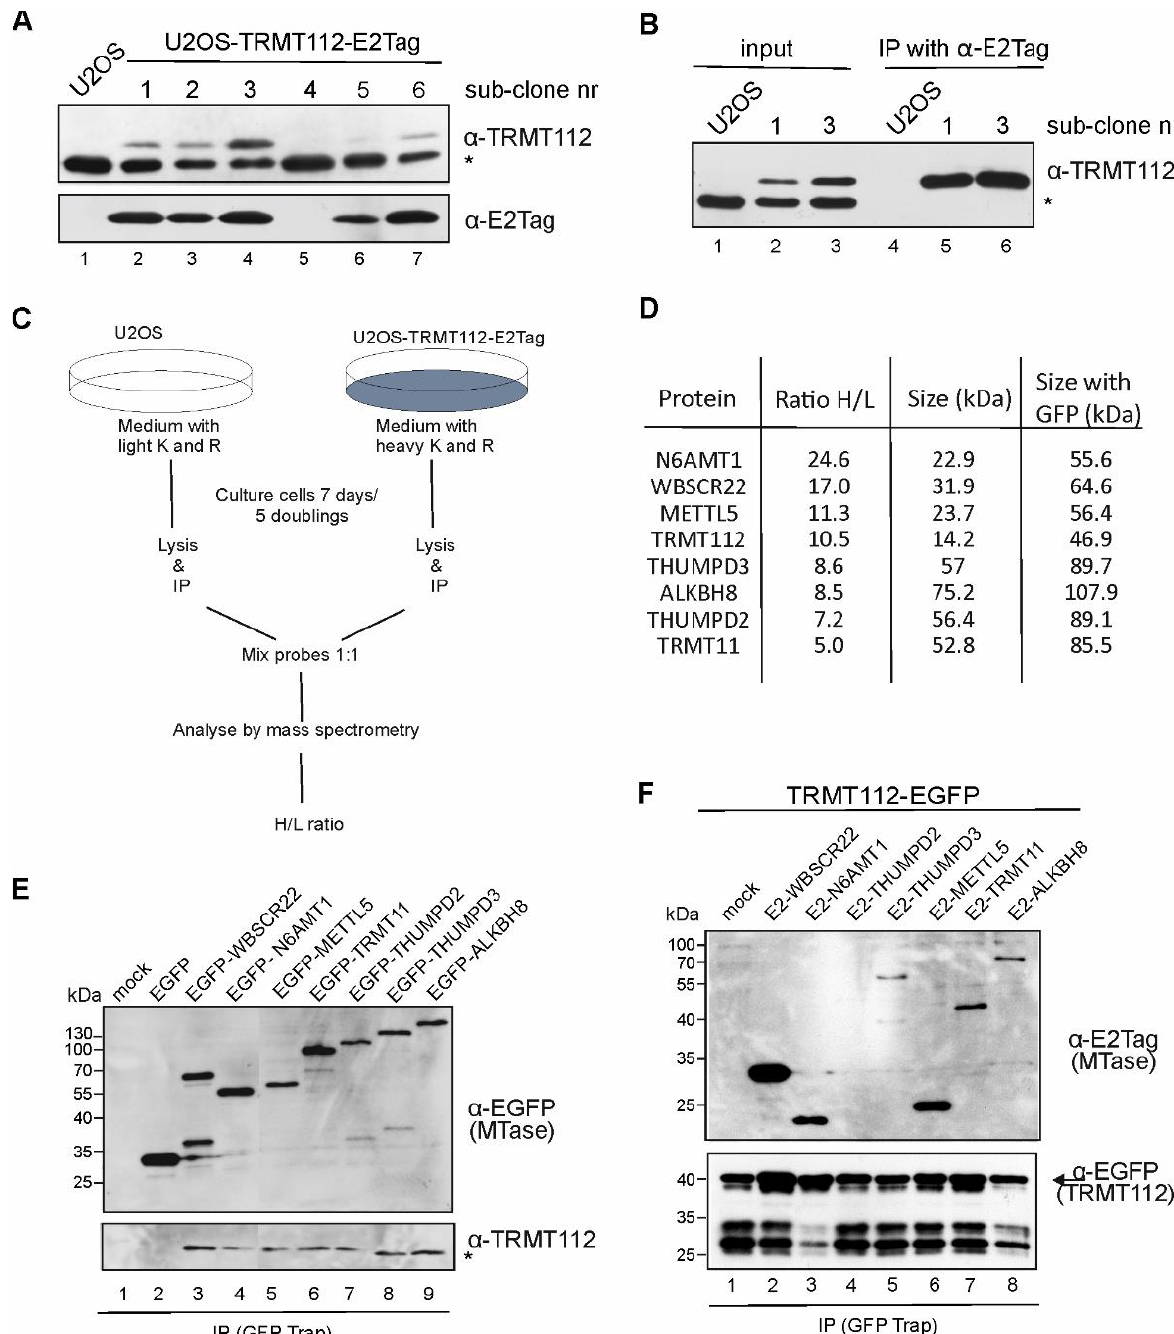
Figure 1. TRMT112 interacts with seven MTases in mammalian cells. ( A ) Generation of stable U2OS cell lines expressing the TRMT112-E2Tag protein. Protein expression was detected by Western blot analysis using antibodies against TRMT112 and E2Tag epitope tag. Images of results with anti-TRMT112 depict both recombinant (upper band) and endogenous protein (lower band marked with